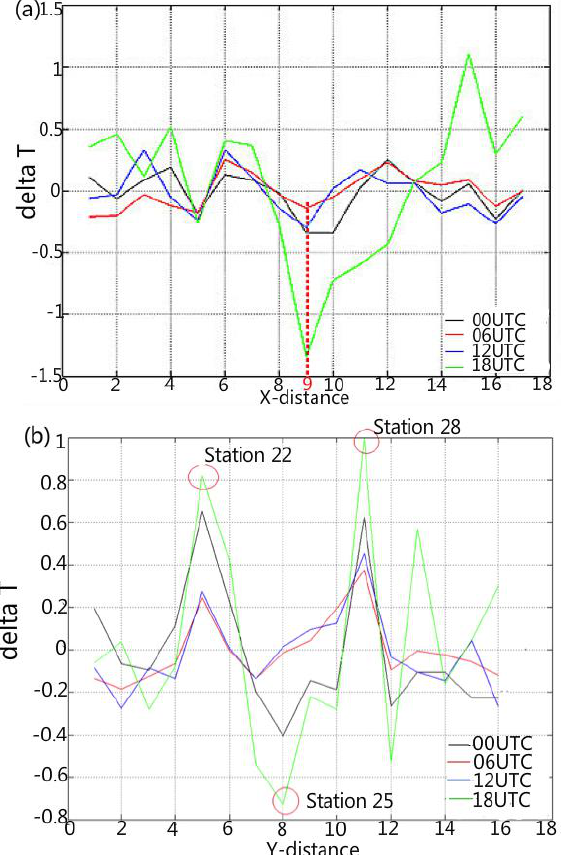
Figure 7. The temperature difference (e.g., Delta T, unit in °C) values for 2 m air temperatures for each station in ( a ) the x -direction and ( b ) the y -direction.